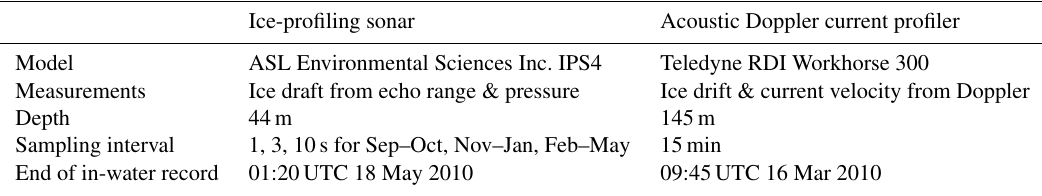
Table 2. Ice-measuring instruments on the Penny Strait